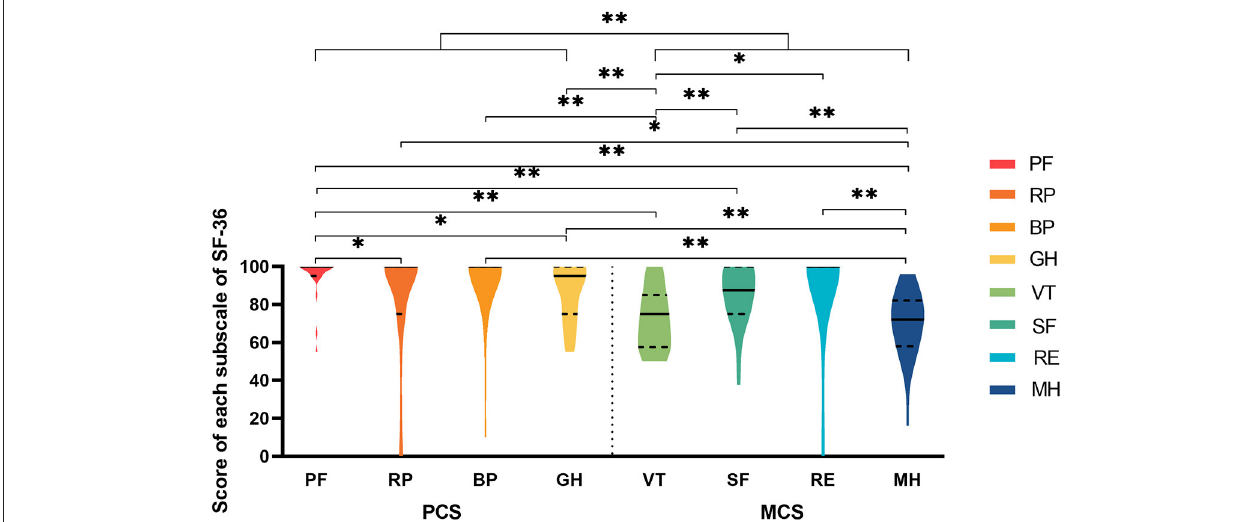
FIGURE 3 | The violin plot of eight subscales in SF-36. PF, physical functional impairment; RP, physically limited usual role activities; BP, bodily pain; GH, general health; VT, vitality; SF, social functional impairment; RE, emotionally limited usual role activities; MH, mental health; PCS, physical composite score; MCS, mental composite score. *significant difference; **extreme significant